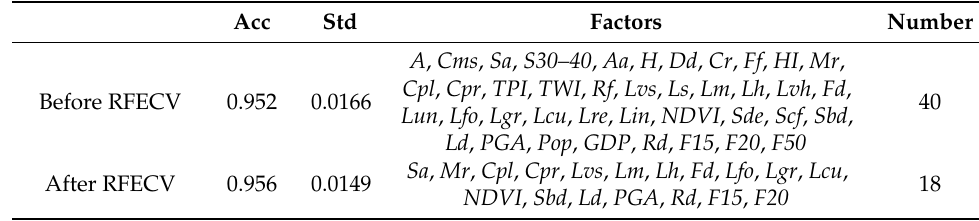
Table 4. Feature selection results of